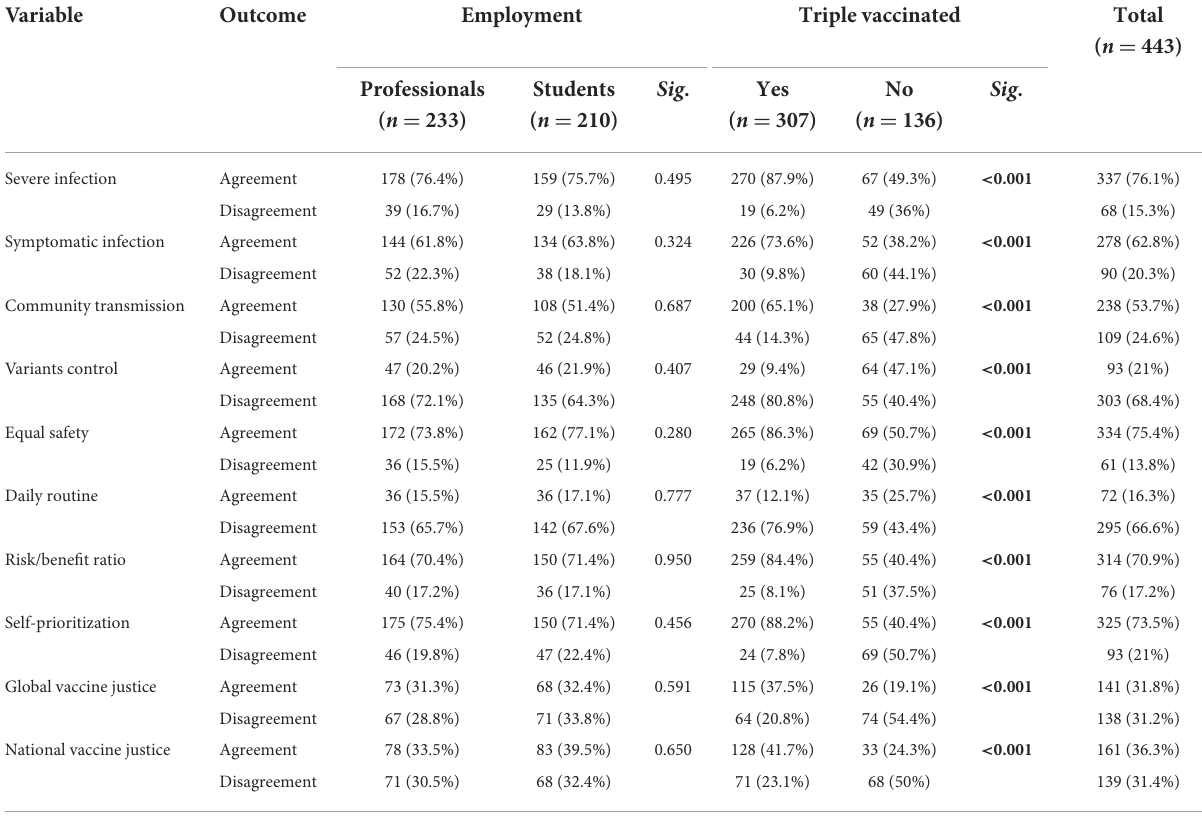
TABLE 4 Determinants of COVID-19 VBH among polish healthcare professionals and students responding to COVID-19 VBH survey, December 2021–January 2022 ( n = 443).